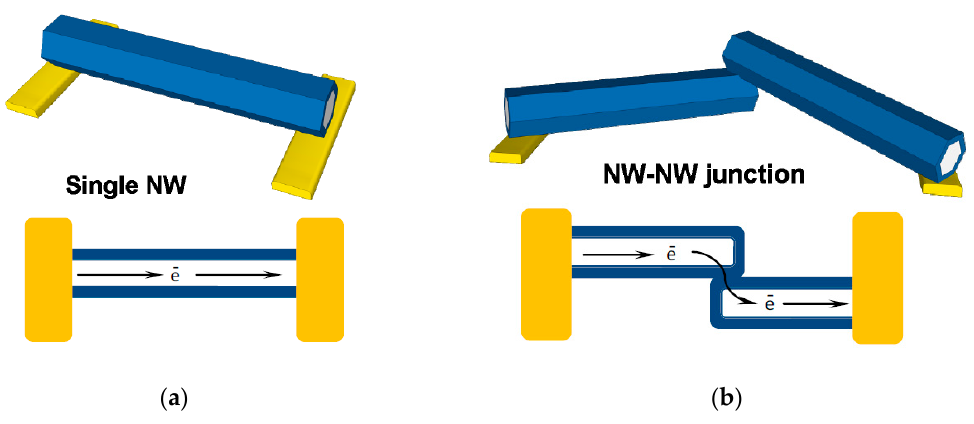
Figure 2. Schematics of ZnO NW sensor geometry types: ( a ) single NW; ( b ) NW-NW junction.